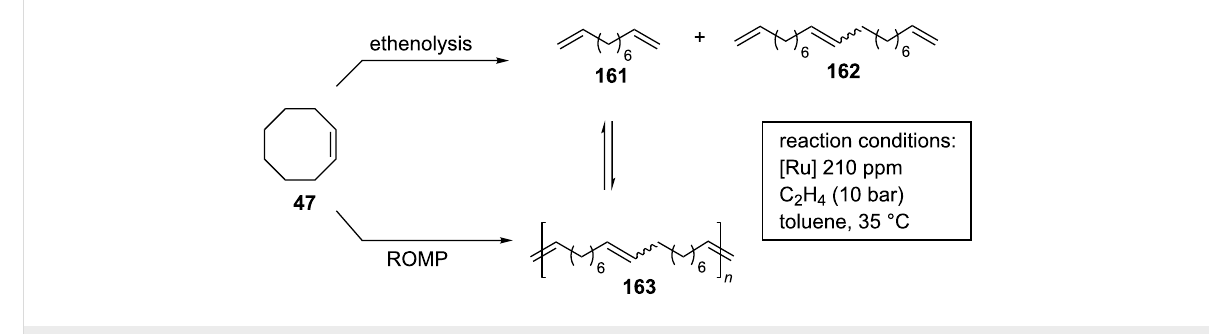
hampered attempts to prepare the catalyst, one of the N -aryl substituents was replaced with the smaller methyl group.